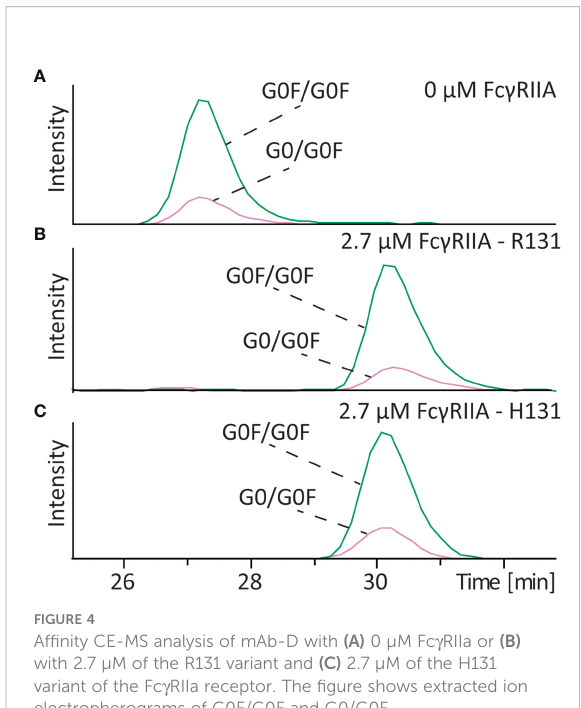
FIGURE 4 Af fi nity CE-MS analysis of mAb-D with (A) 0 µM Fc g RIIa or (B) with 2.7 µM of the R131 variant and (C) 2.7 µM of the H131 variant of the Fc g RIIa receptor. The fi gure shows extracted ion electropherograms of G0F/G0F and